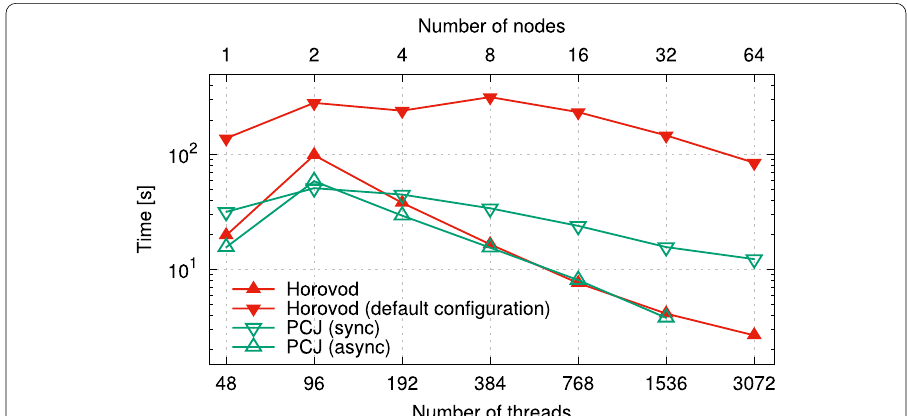
Fig. 9 Comparison of the distributed training time taken by Horovod and PCJ as measured on Cray XC40 at ICM. Accuracy of ≈ 96% was